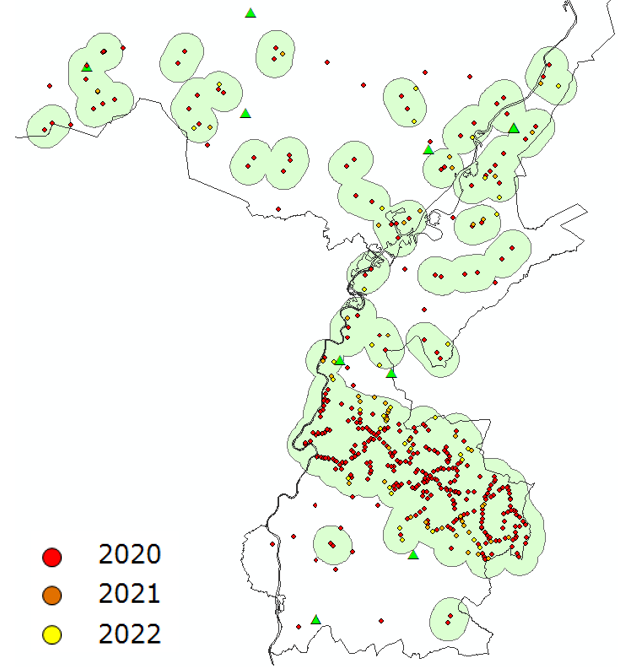
Figure 5. Clustered groups and individual benchmarks to be mea- sured in 2020. Benchmarks that exceed the threshold in 2021 and 2022, but are located close to clustered groups need to be measured as